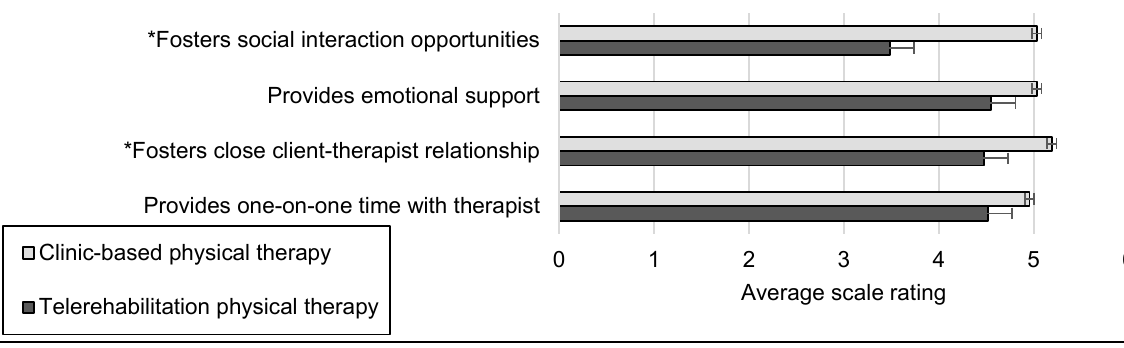
Note . Error bars represent the standard error of mean. * indicates significant difference between the two service delivery models given p < .0024.